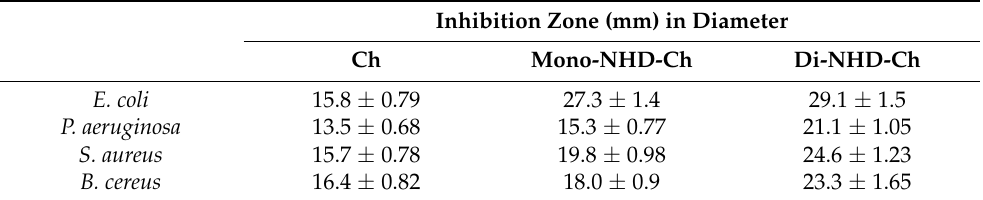
Table 2. Inhibition indices of chitosan and chitosan alkyl derivatives against E. coli , P. aeruginosa , S. aureus , and B. cereus . Values are expressed as mean ± SD (n = 3).